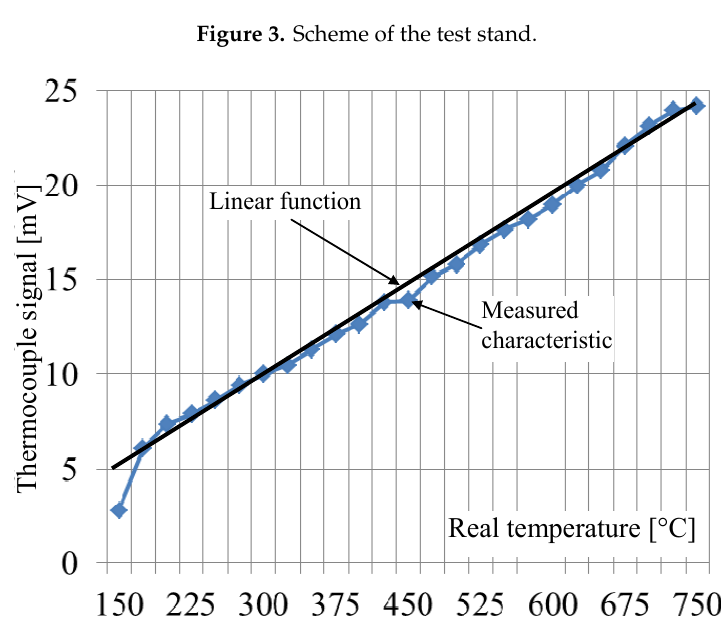
Figure 3. Scheme of the test stand.